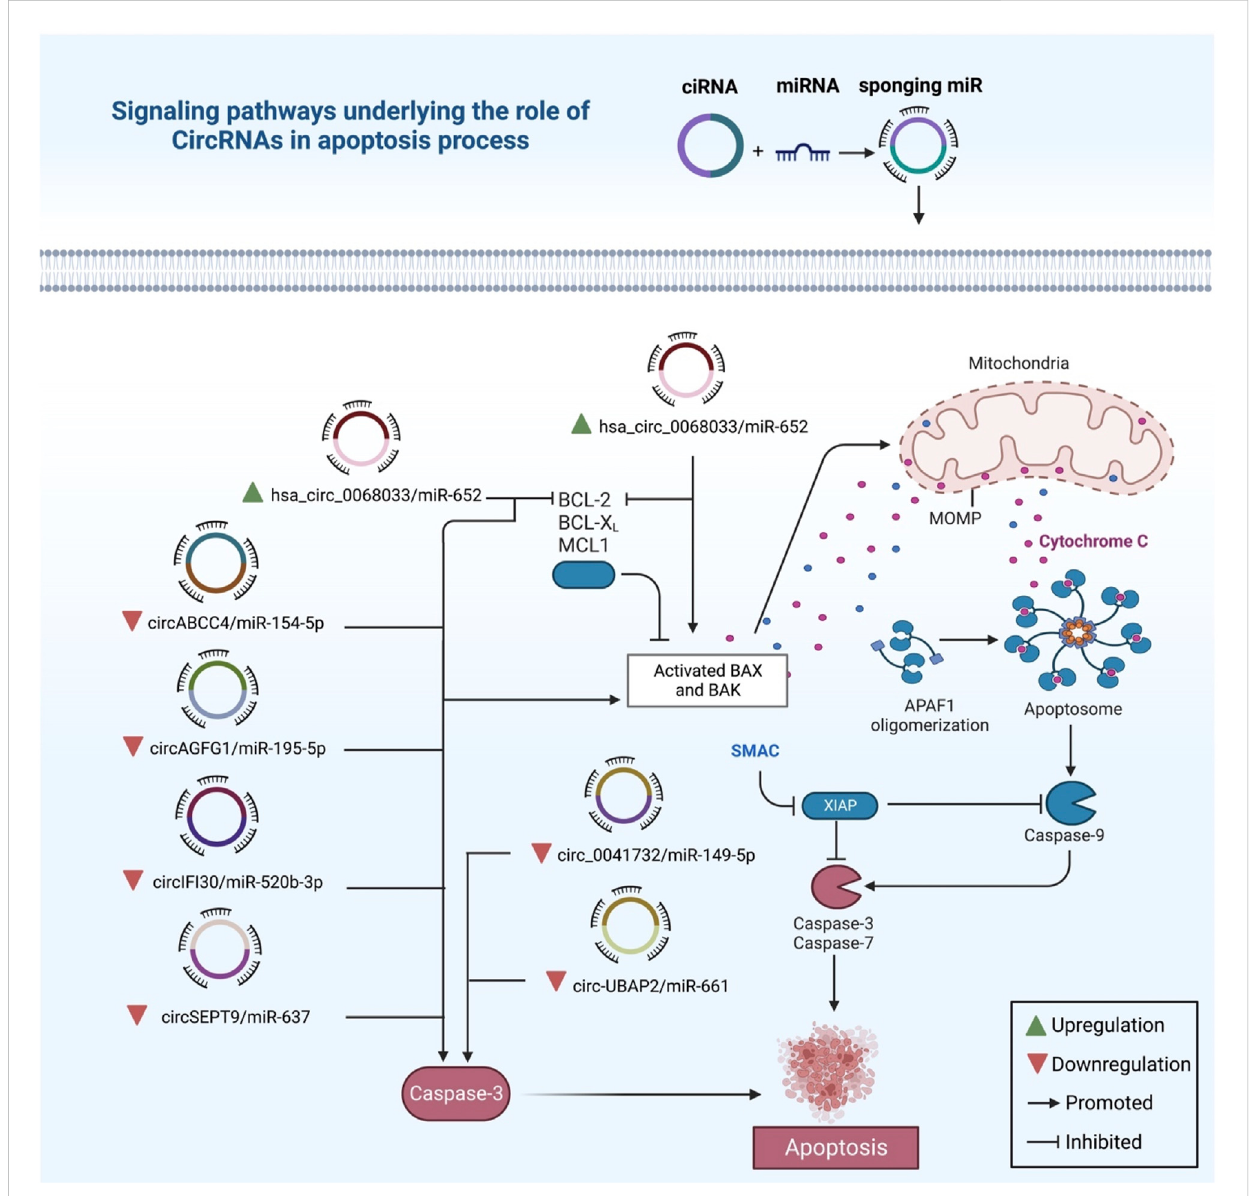
FIGURE 5 The intrinsic apoptotic pathway in breast cancer and the regulatory roles of exo-circRNAs. The production of caspase-3 is reduced when tumor suppressor circRNAs are downregulated, which in turn reduces apoptosis. Contrarily, oncogenic circRNAs like hsa_circ_0068033 promote oncogenic activity by inhibiting apoptosis via activating BAX and BAK